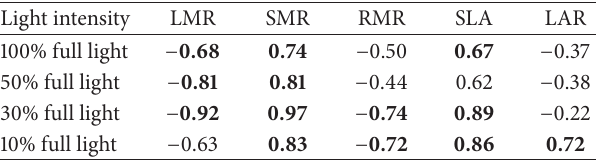
Table 2: Correlations between growth rate and other measured variables in different light levels. Correlations significant at 𝑃 < 0.05 are shown in bold.